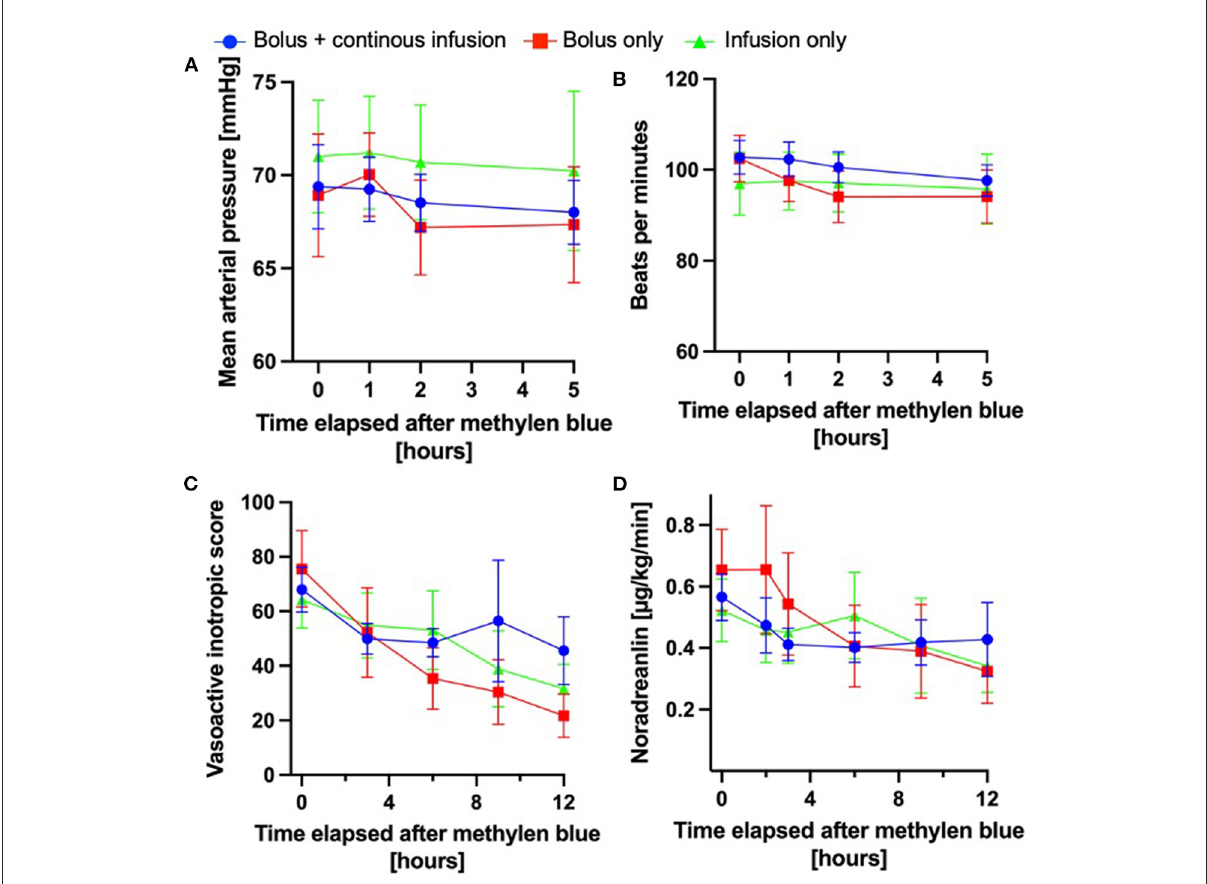
FIGURE2 Hemodynamic changes after methylene blue administration. The injection time points of the methylene blue bolus were defined as “0 h”; all subsequent time indicators were defined in relation to the administration of methylene blue administration. (A) Mean arterial pressure over time in the different methylene blue treatment groups over time. (B) Heart rate over time after methylene blue administration ( A + B : bolus + continuous infusion: n = 111–110; bolus only: n = 47–59; continuous infusion only n = 35–39). (C) Norepinephrine infusion rate in µ g/kg/min over time after methylene blue administration. (D) Development of vasoactive inotropic score after methylene blue administration ( C + D : bolus + continuous infusion: n = 111–110; bolus only: n = 47–59; continuous infusion only n = 35–39); All data are shown as mean ± 95% confidence